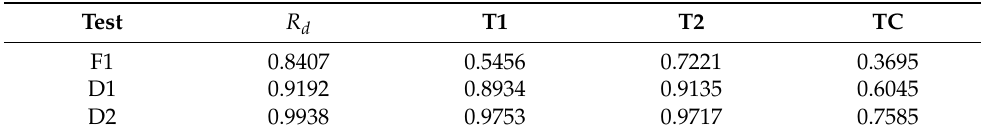
Table 1. Pearson correlation coefficients with respect to R a .